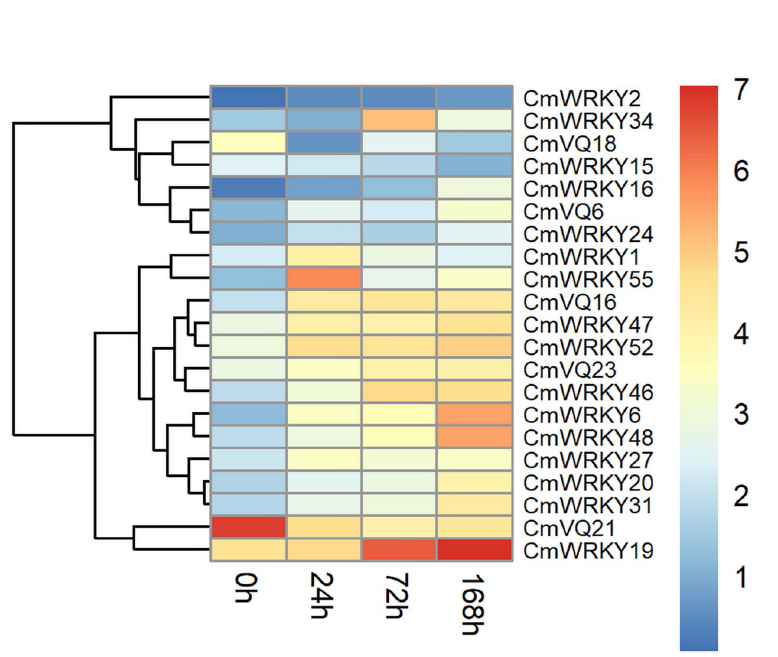
Fig 7. Expression patterns of powdery mildew fungus responsive CmWRKY and CmVQ genes after powdery mildew fungus infection. The expression values were measured as fragments per kilobase of exon model per million mapped reads (FPKM) and shown as log2 (value + 1). The color scale is shown at the right and higher expression levels are shown in red.